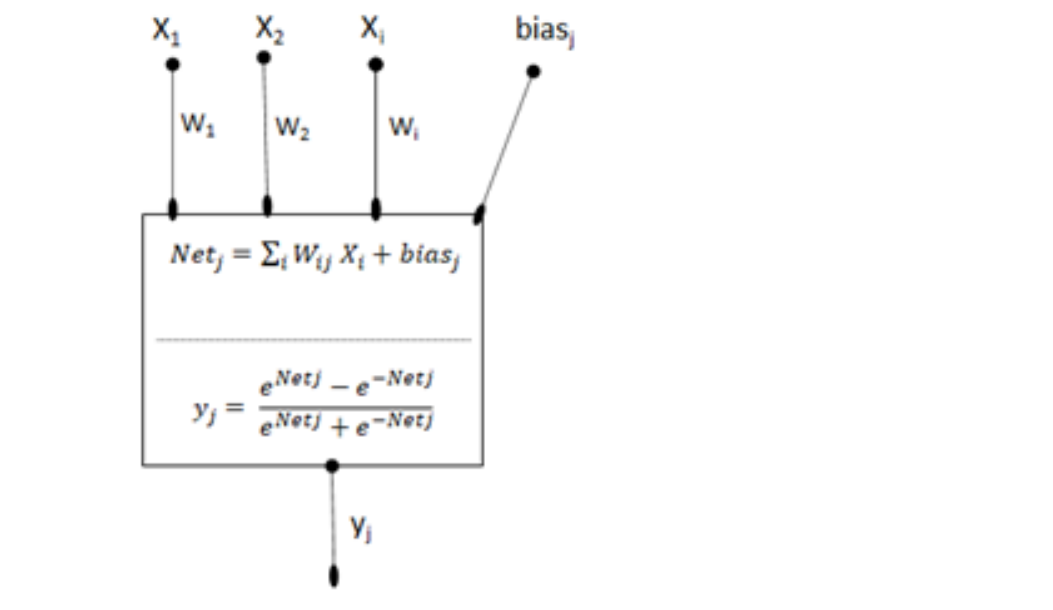
Figure 4. General scheme of a neuron unit. Xi represent the variables of the input layer, Wij is the weight from neuron j and the neuron i , and bias j is the bias on neuron j . Net j is the activation as the sum of the weighted inputs of neuron j . y j is the output of neuron j resulting from the application of hyperbolic tangent transfer function.